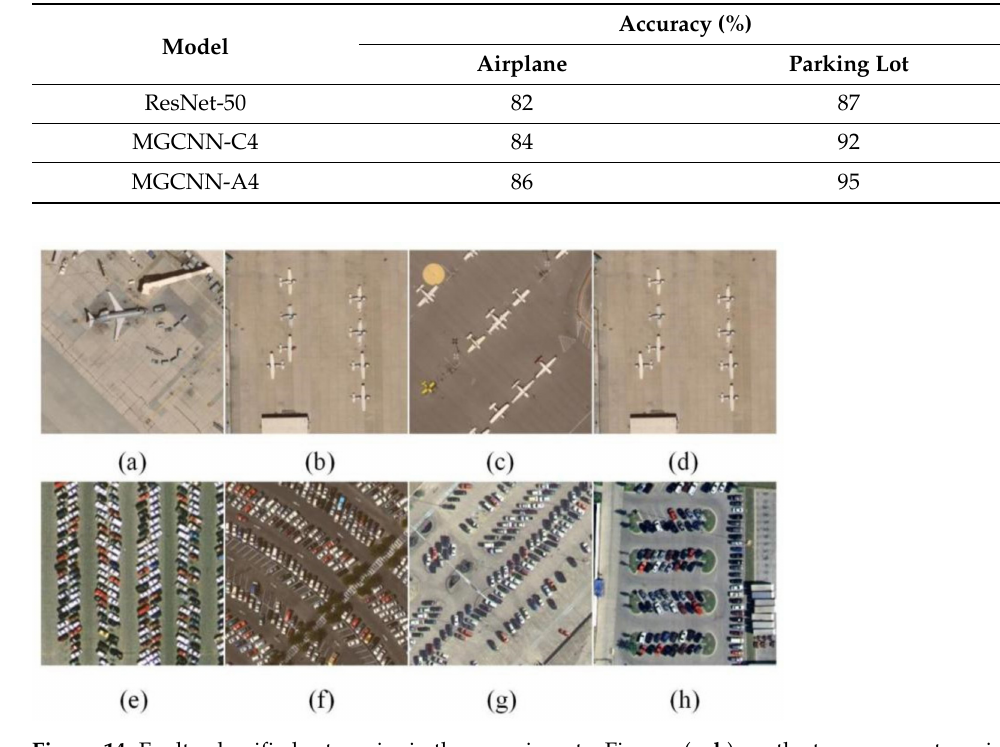
Figure 14. Faulty classified categories in the experiments. Figures ( a – h ) are the two same categories in RSI-CB and UC-Merced